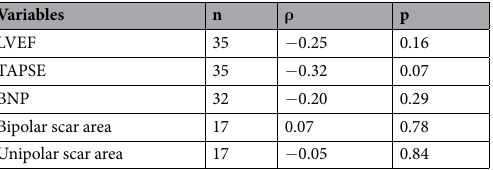
Table 3. miR-320a expression does not correlate with continuous variables associated to Arrhythmogenic CardioMyopathy (ACM) severity. LVEF, Left Ventricular Ejection Fraction; TAPSE, Tricuspid Annular Plane Systolic Excursion; BNP, Brain Natriuretic Peptide; Bipolar Scar Area, percentage of right ventricle non- conductive ( < 1.5 mV) area obtained by bipolar analysis of electroanatomic mapping on right ventricle total area; Unipolar Scar Area, percentage of right ventricle non-conductive ( < 5.5 mV) area obtained by unipolar analysis of electroanatomic mapping on right ventricle total area. For each variable the Spearman’s rank correlation coefficient ( ρ ) and its statistical significance (p) are reported.